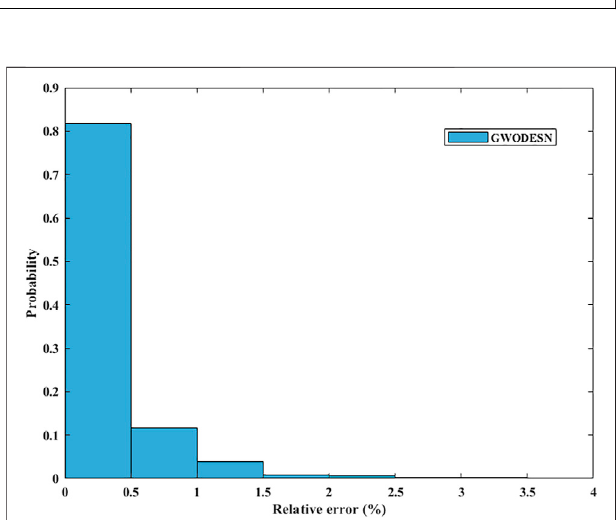
FIGURE 3 | The real value and the anticipated value for Lorenz x( t ).